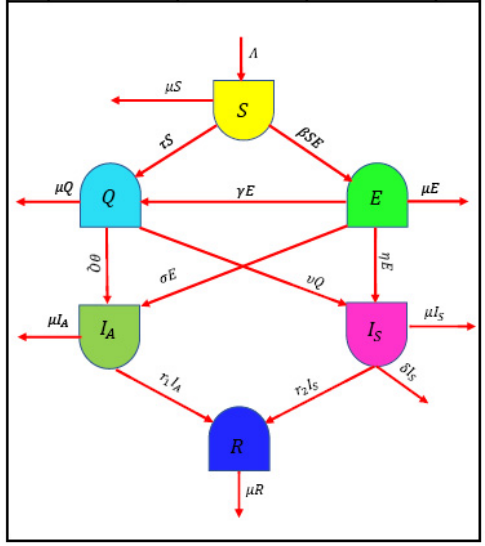
Figure 1. Flowchart describing the dynamics of spread in the model for